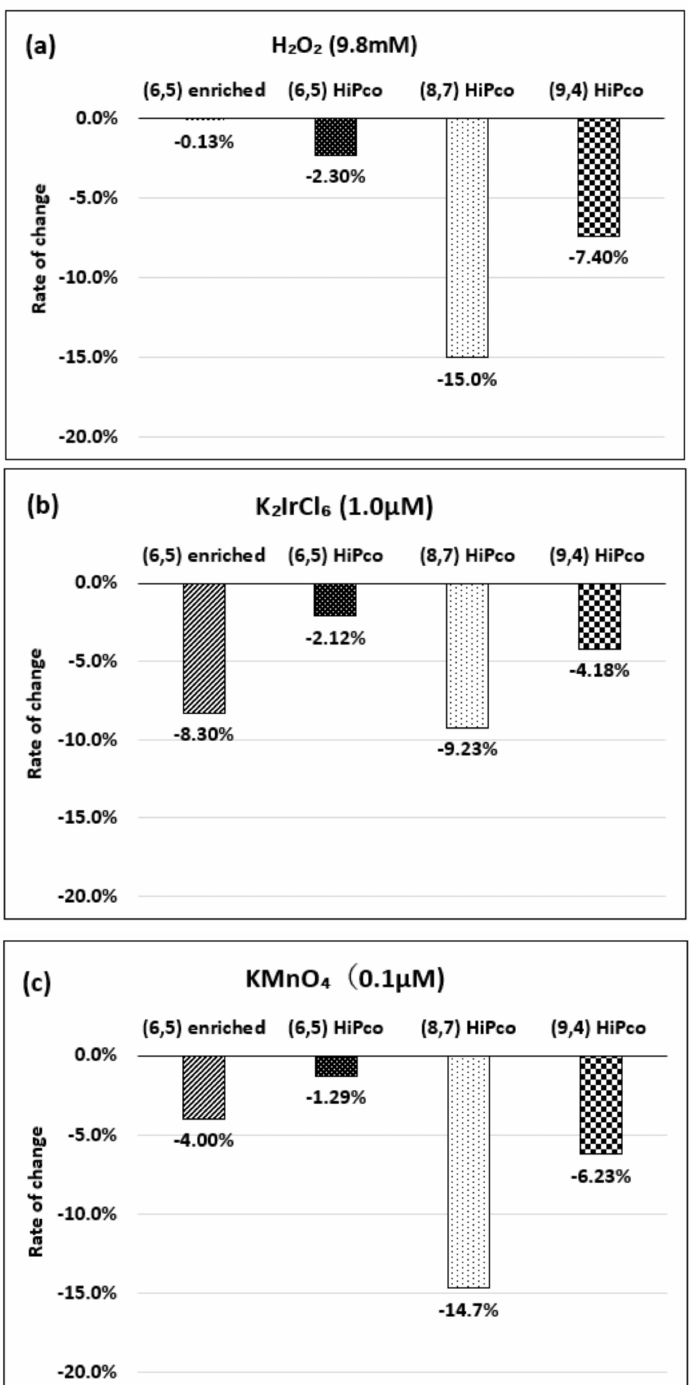
Figure 8. Change in the absorbance for each chirality with the addition of ( a ) 9.8 mM H 2 O 2 , ( b )